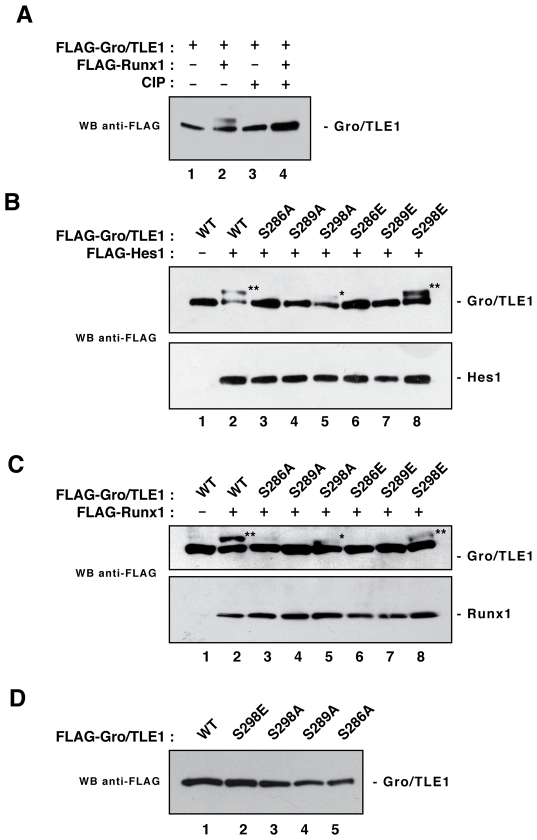
Effect of SP domain mutations on cofactor-activated phosphorylation of Gro/TLE1.(A) Equivalent amounts of protein extracts from cells transfected with the indicated proteins were incubated in the absence (lanes 1 and 2) or presence (lanes 3 and 4) of calf intestinal phosphatase (CIP), followed by fractionation on a 6% SDS polyacrylamide gel and Western blotting (WB) analysis with an anti-FLAG antibody. Phosphatase treatment abolished the slower Gro/TLE1 species induced by Runx1 expression. (B and C) HEK293 cells were co-transfected with FLAG epitope-tagged wild type or mutated Gro/TLE1 proteins in the absence or presence of either FLAG-Hes1 (B) or FLAG-Runx1 (C), followed by fractionation on a 6% SDS polyacrylamide gel and Western blotting with an anti-FLAG antibody. The slower Gro/TLE1 band visible when Hes1 or Runx1 were co-expressed (lanes 2 and 8; two asterisks) was either reduced (lane 5; one asterisk) or absent in the case of all SP domain mutations (lanes 3–7), except for S298E (lane 8). (D) Western blotting analysis with an anti-FLAG antibody of the indicated proteins expressed in HEK293 cells and fractionated on a 5% SDS polyacrylamide gel.